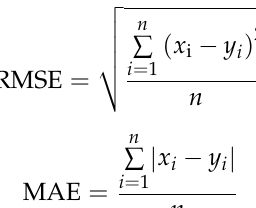
Plot 4-1: AGB = 2.65 Plot 9-1: AGB = 4.78 Plot 2-2: AGB = 8.27